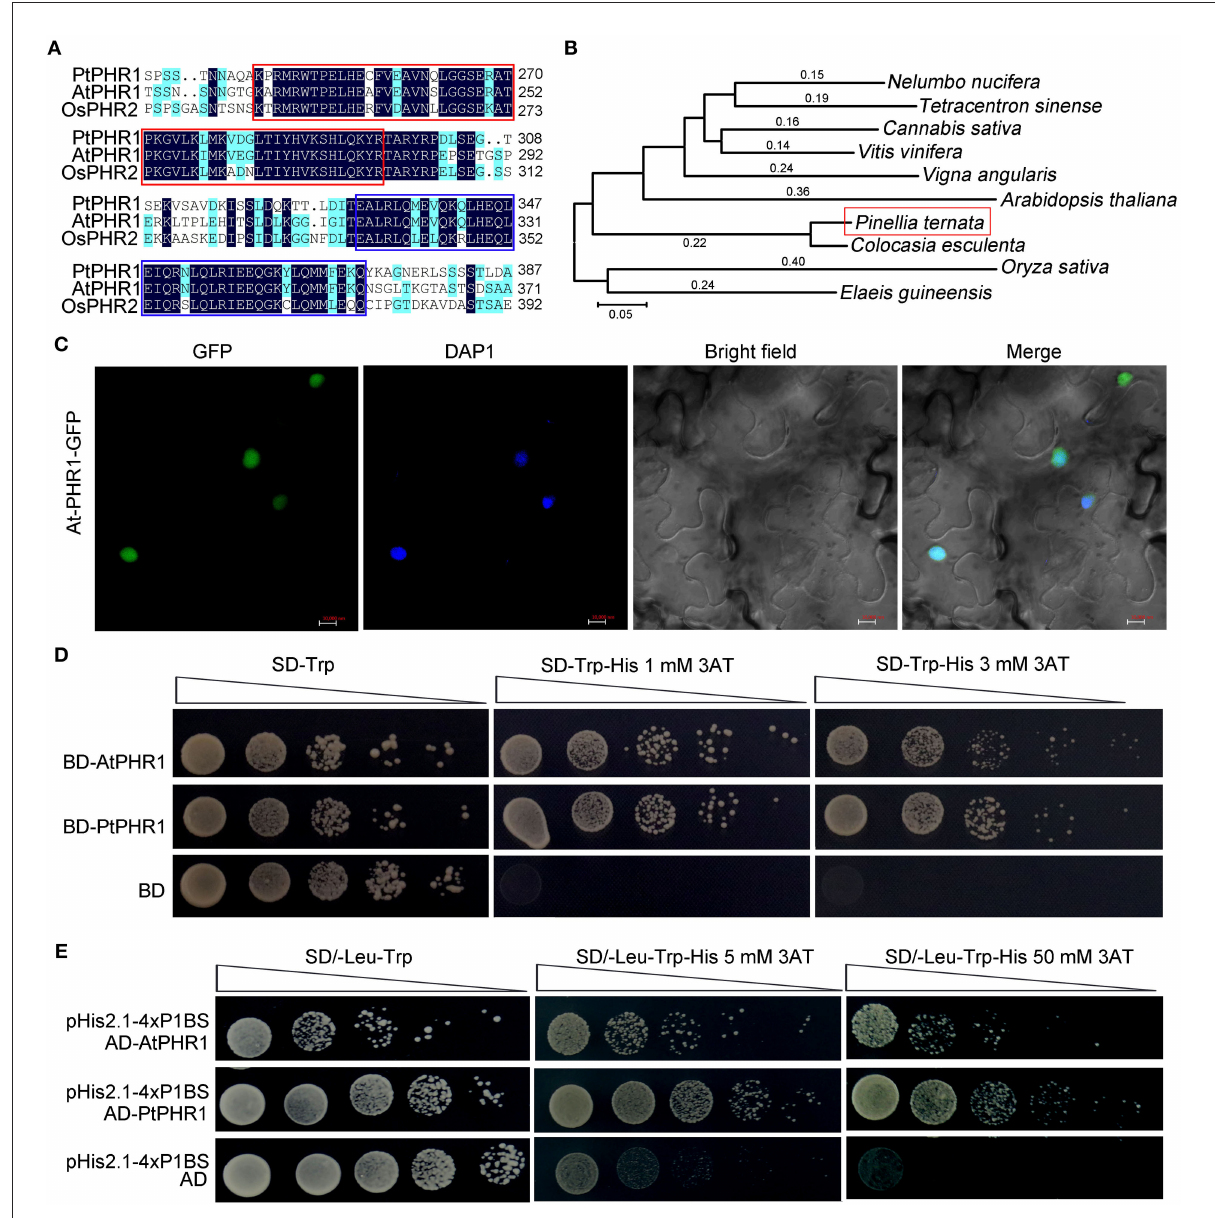
FIGURE4 Characterization of PtPHR1 structure, evolution, localization, and activity. (A) Multiple alignments of PtPHR1, AtPHR1, and OsPHR2. Similar residues are shaded blue and identical residues are shaded black. The conserved MYB-domain (red) and predicted CC domain (purple) are shown. (B) Phylogenetic analysis of PtPHR1 amino acid sequences used the neighbor-joining method. The accession numbers of sequences used are as follows: Arabidopsis thaliana , NP_194590.2; Oryza sativa , XP_015647735.1; Nelumbo nucifera , XP_010264912.1; Tetracentron sinense , KAF8394238.1; Cannabis sativa , XP_030498437; Vitis vinifera , XP_002270511.1; Vigna angularis , XP_017411143.1; Colocasia esculenta , MQM19898.1 and Elaeis guineensis , XP_010920302.1. (C) Nuclear localization of PtPHR1-GFP. Bars = 10 µ m. (D) PtPHR1 has